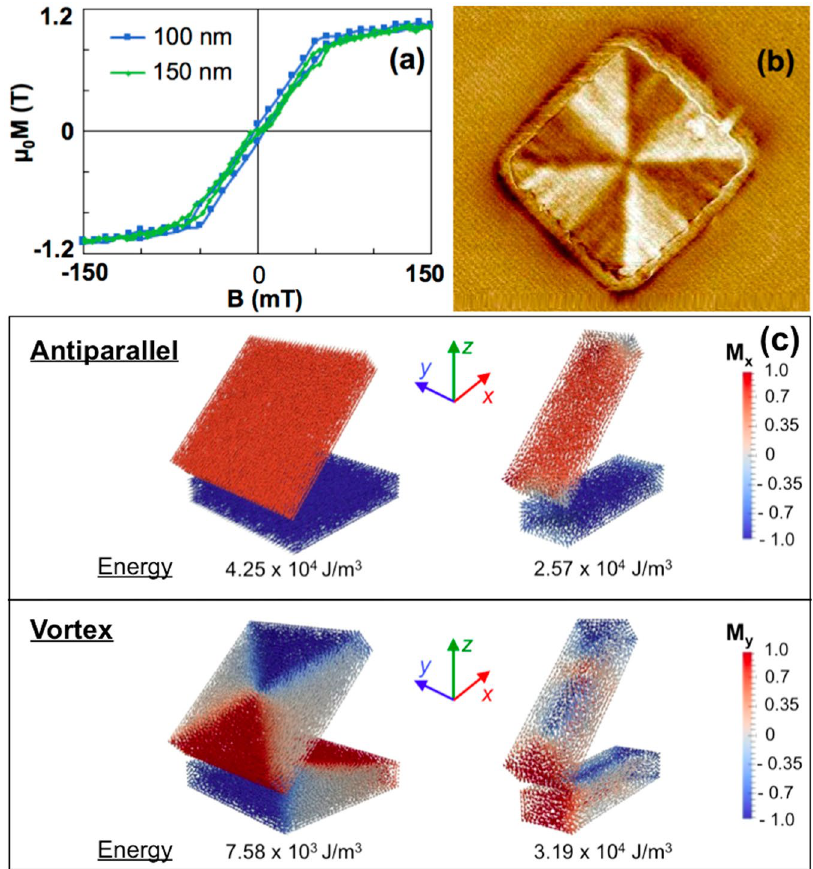
Figure 3. ( a ) Magnetic hysteresis curves of permalloy square-shaped microelements. The magnetization is a quasilinear function of the external field in the unsaturated region. ( b ) MFM image of a soft magnetic jaw (2 μ m × 2 μ m × 250 nm) at remanence showing a vortex structure. ( c ) Micromagnetic simulations at zero field and with a tweezers opening of 45° for different jaw geometries (square and elongated) showing different metastable magnetic configurations. The magnetization is normalized. The energy of each state shows that